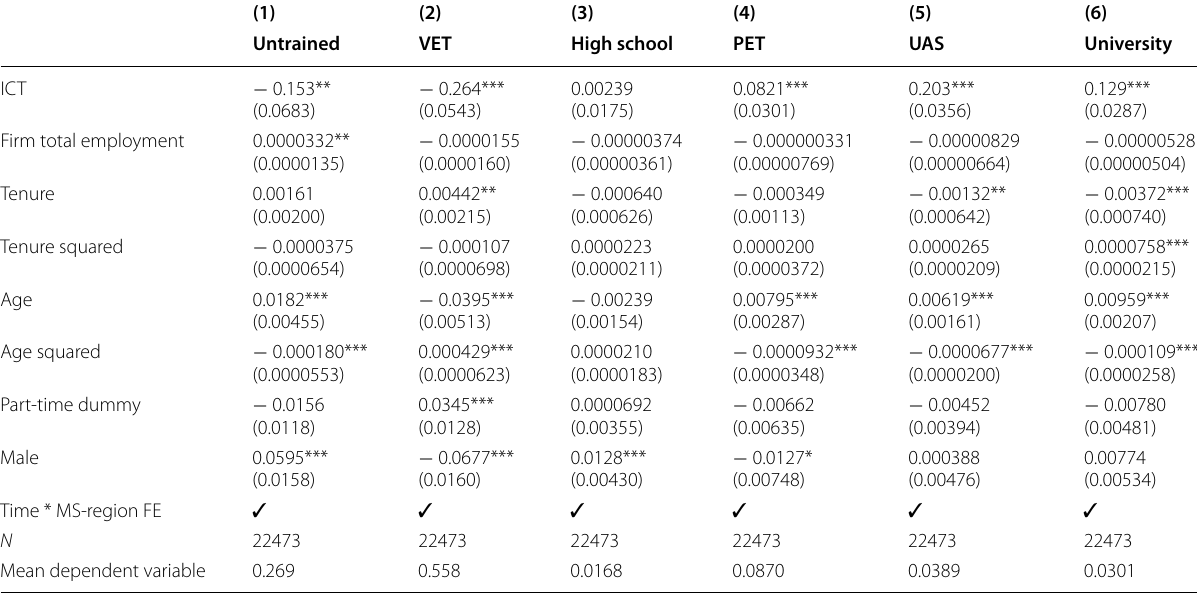
The table shows OLS coefficients of fixed effects estimates of a firm pseudo-panel with cells defined based on MS-region, industry and firm size. Standard errors in parentheses are clustered at the cell level. N reports the number of pseudo-panel cells that contain at least one firm The main explanatory variable measures the cell percentage of ICT workers according to ICT tasks (1996–2010) or ICT occupations (2012–2018). Estimates further control for time*MS-region fixed effects and cell averages of total employment, tenure, age, part-time status, and gender Each column shows the results for a different dependent variable measuring the percentage